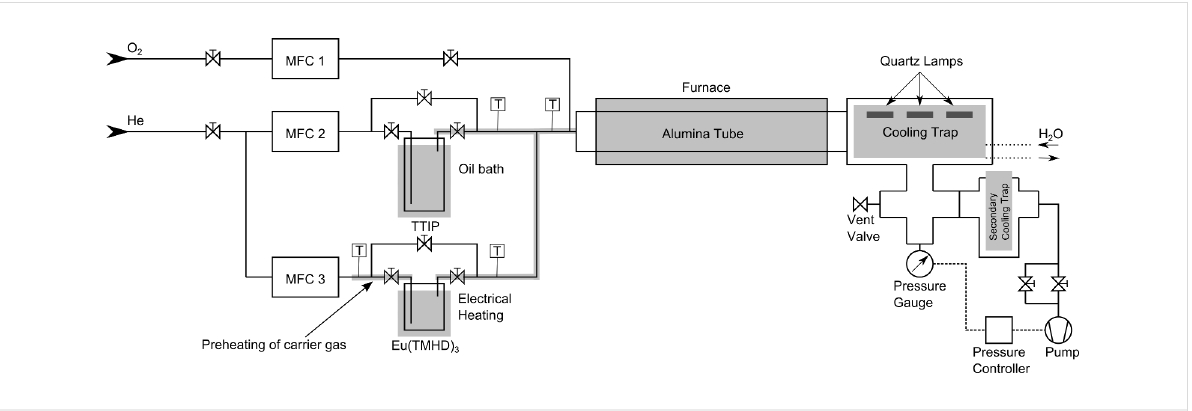
Figure 1: CVR chamber consisting of precursor sources, reaction zone and thermophoretic powder-collection system. The substrates on which the nanoparticles are collected have been placed on the cooling trap below the Quartz lamps.